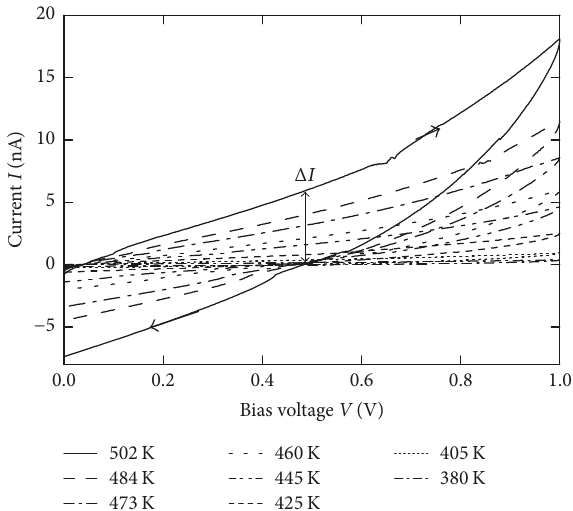
Figure 4: Dynamic I-V curves of the Au/Zr (3nm)/YSZ (40 nm)/TiN MOM stack measured at various temperatures. Ramp voltage sweep rate 𝛽 = 0.02